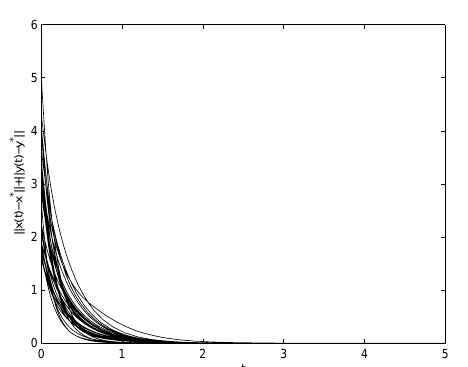
Fig. 1. Convergence behavior of the error (cid:5) x ( t ) − x ∗ (cid:5) + (cid:5) y ( t ) − y ∗ (cid:5) based on (3)-(4) with 30 random initial points in Example 1